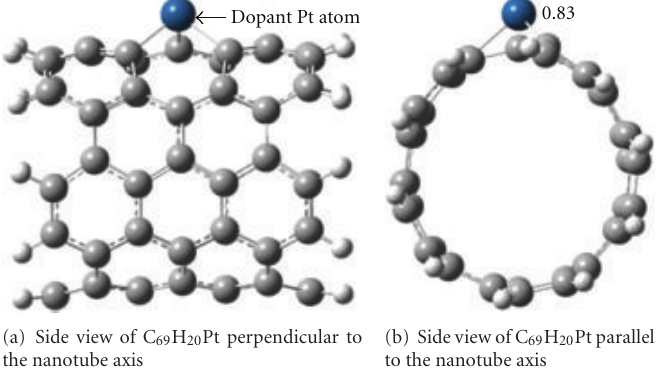
Figure 15: Optimized geometry of C 69 H 20 Pt (a) perpendicular and (b) parallel to the nanotube axis [114]. Legend: dark grey = carbon, light grey = hydrogen, blue =